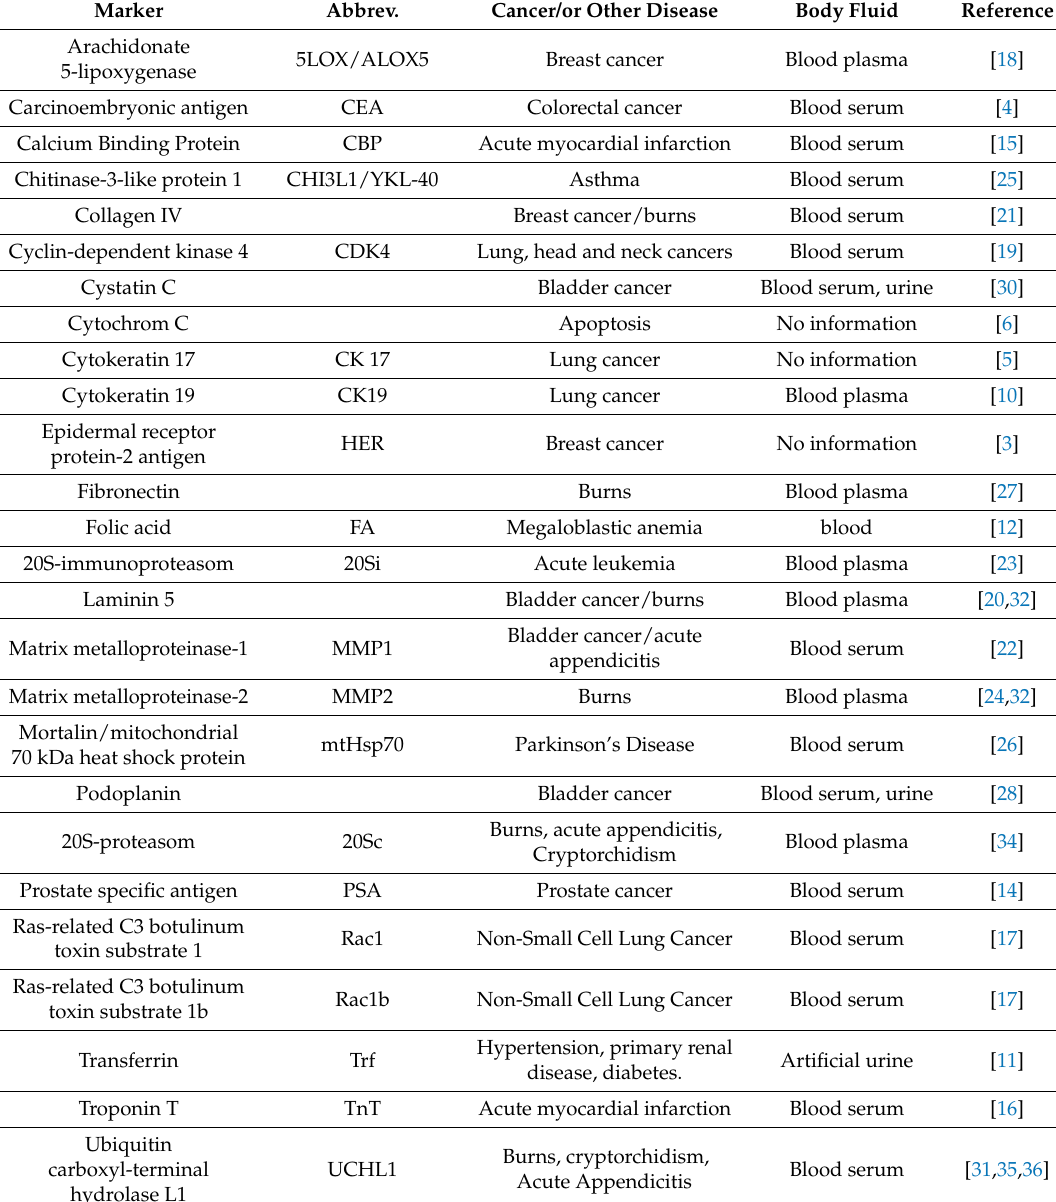
Table 5. Markers and related